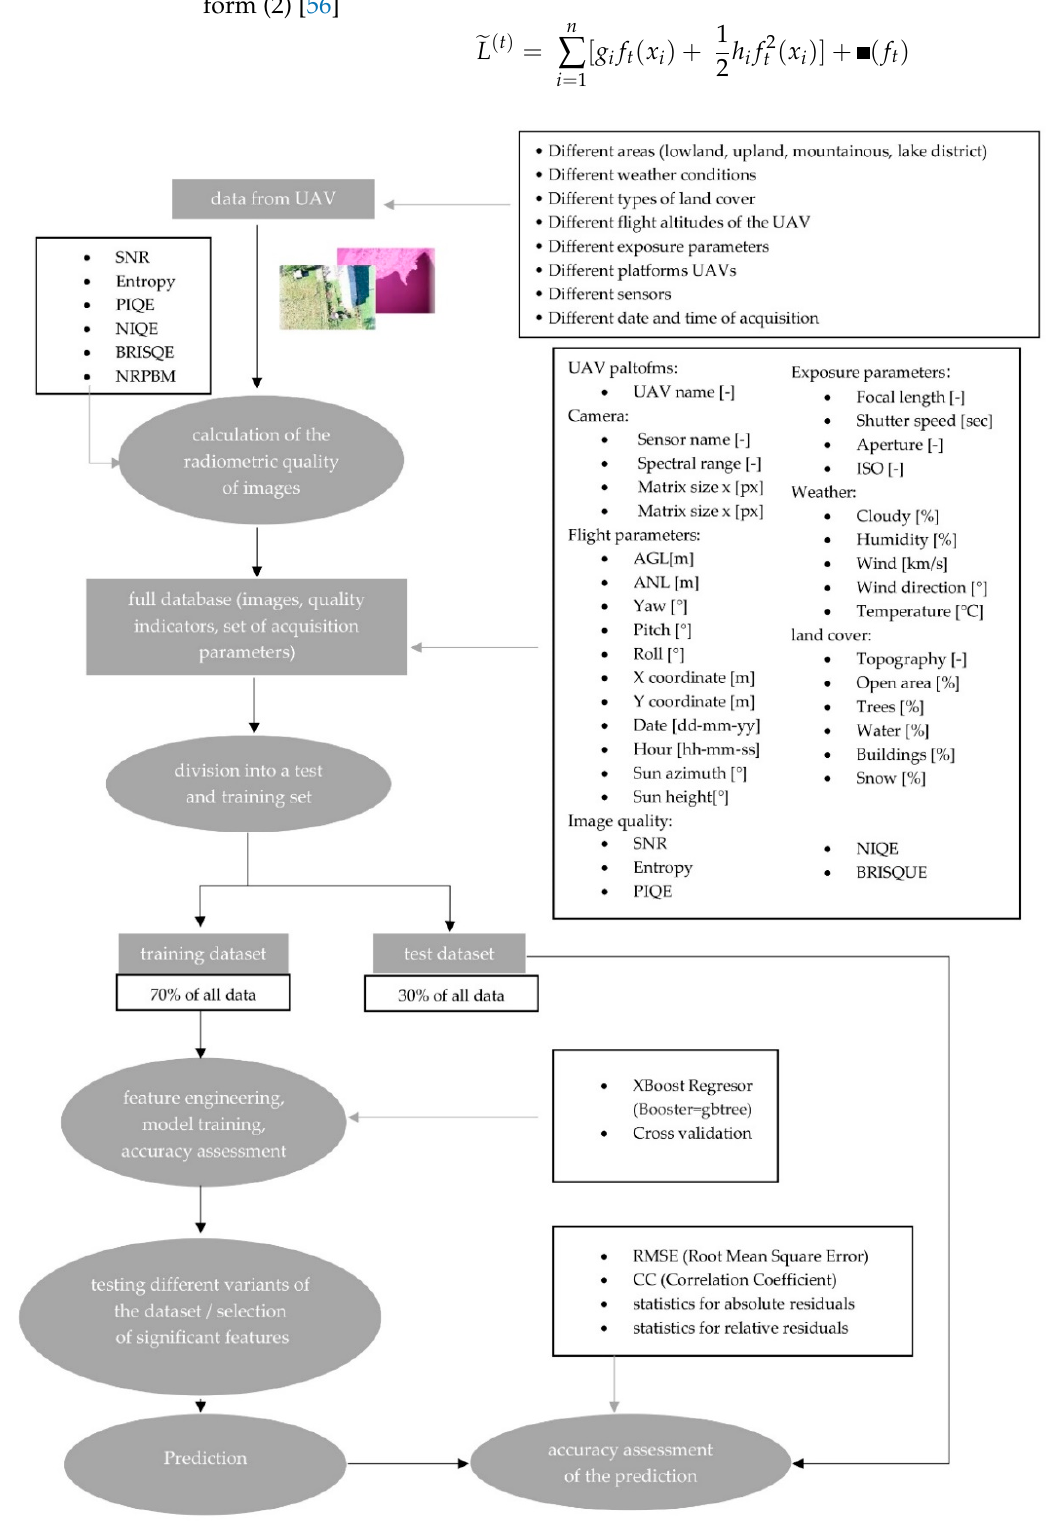
Figure 5. Image quality prediction algorithm based on a priori factors.